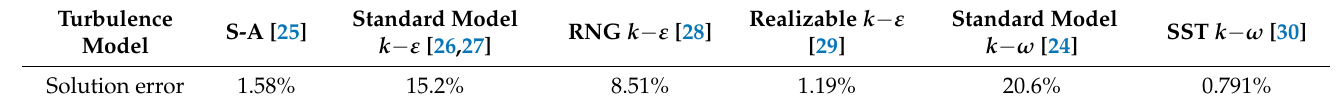
Table 2. Comparison of different turbulence